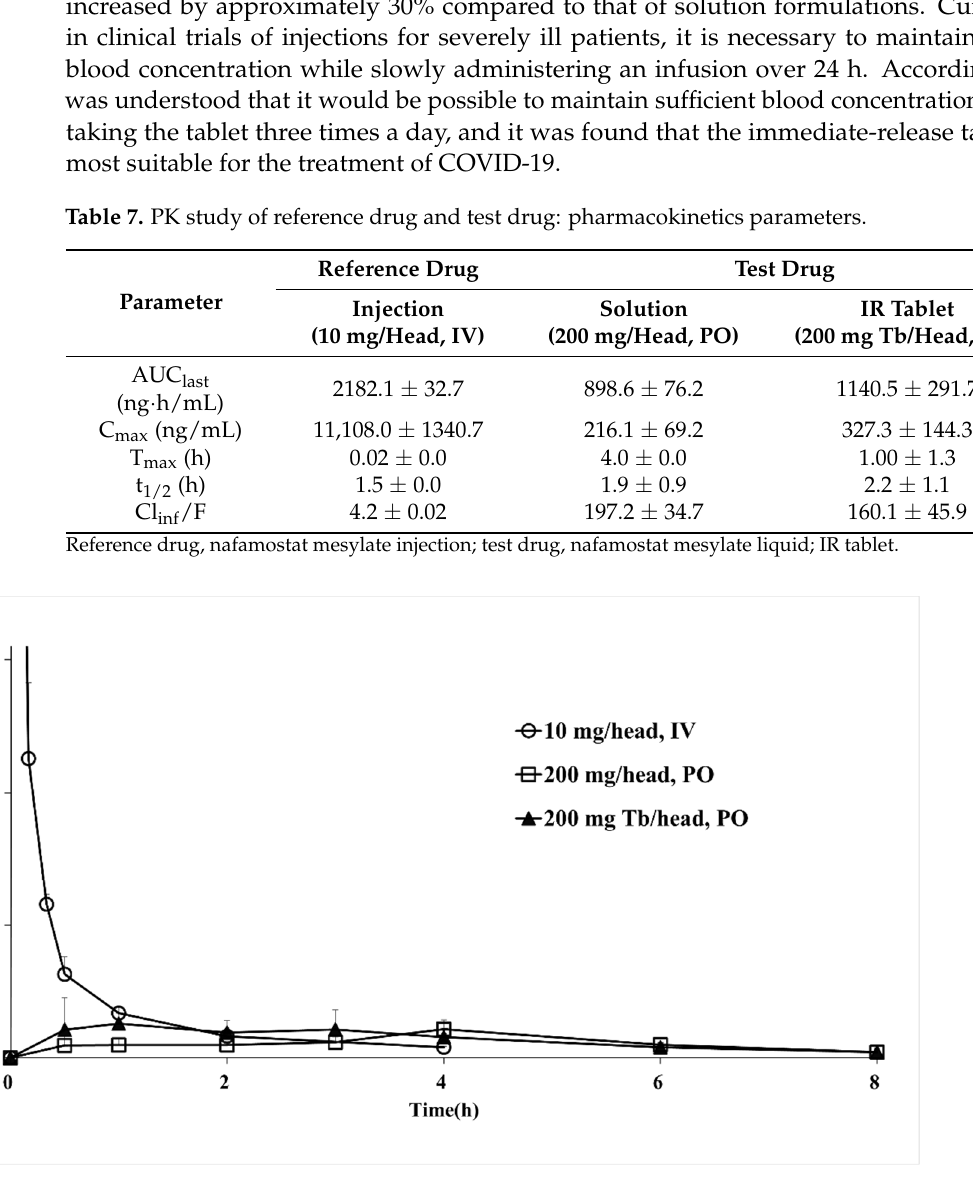
Figure 5. Plasma concentration–time profiles of nafamostat mesylate injections, liquids, and IR tab-